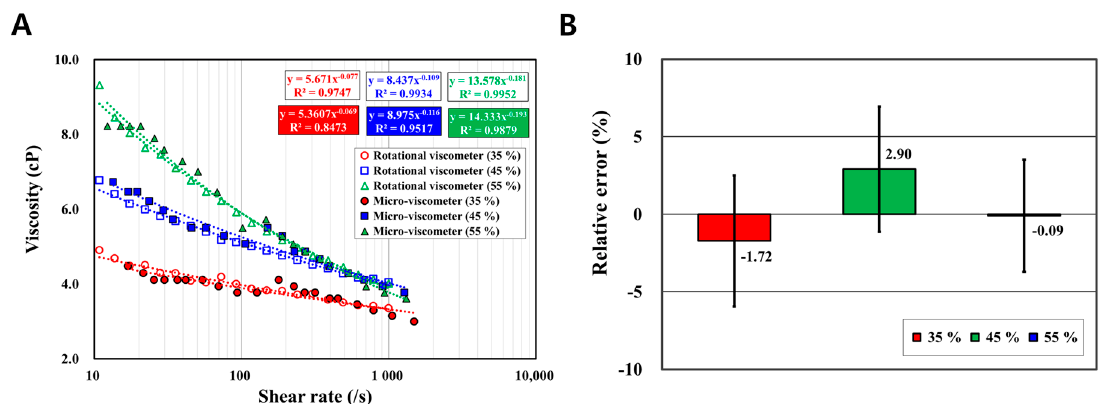
Figure 6. Viscosity measurement with variation in hematocrit levels. ( A ) Viscosity measurements of the three samples with different hematocrit levels (35%, 45%, and 55%) were performed. The results show 5.36, 8.98, and 13.52 (for k) and − 0.08, − 0.11, and − 0.18 (for n), respectively. Thus, an increase in both indices proves that blood samples with higher hematocrit levels have higher viscosities as well as higher magnitudes of shear-thinning behavior. The relative errors are 5.5%, 6.4%, and 5.6% (for k), and 10.4%, 6.4%, and 6.6% (for n), respectively. ( B ) A comparison of the 20 data points obtained from each sample show average relative errors of − 1.72 ± 4.21%, − 2.90 ± 4.03%, and − 0.09 ± 3.61%,